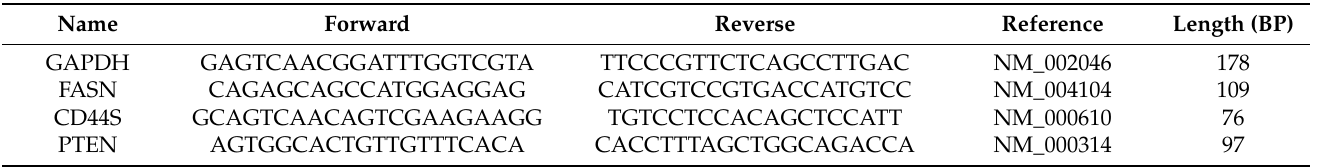
Table 1. Oligo sequences used for